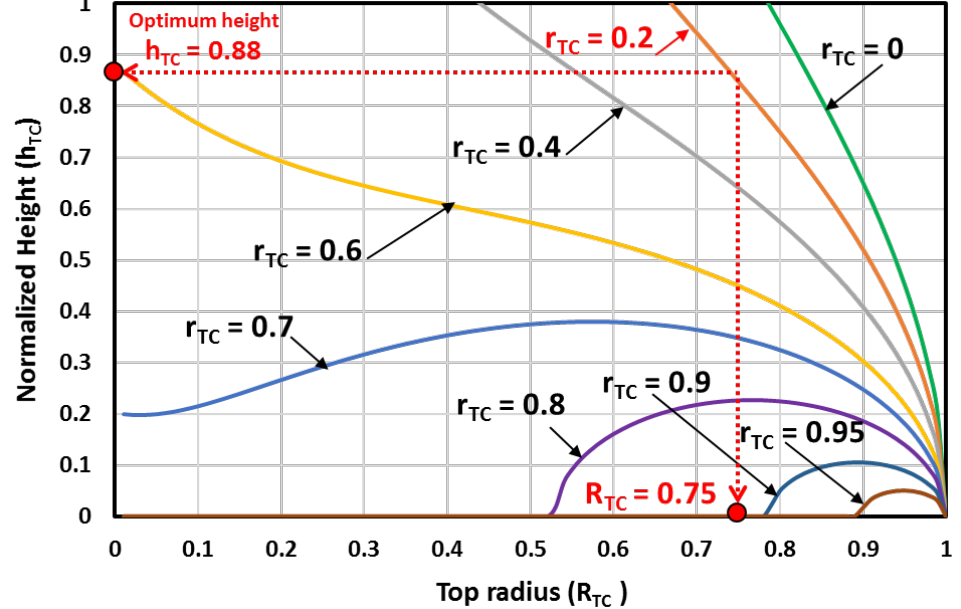
Figure 4. The MH bed height variations against the top radius and the bottom radius.